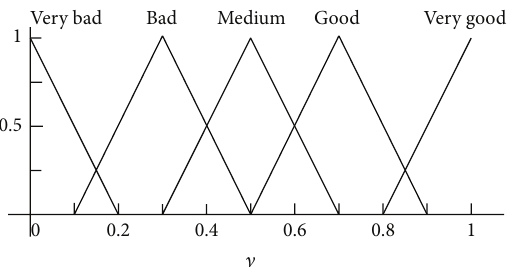
Figure 4: Fuzzy membership function for input 𝛾 factor.